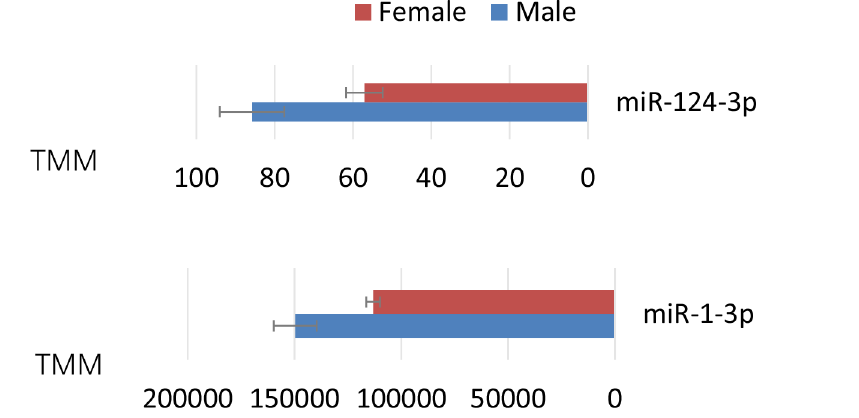
Fig 4. Sex-biased expression of WBPH miRNAs in male and female adult